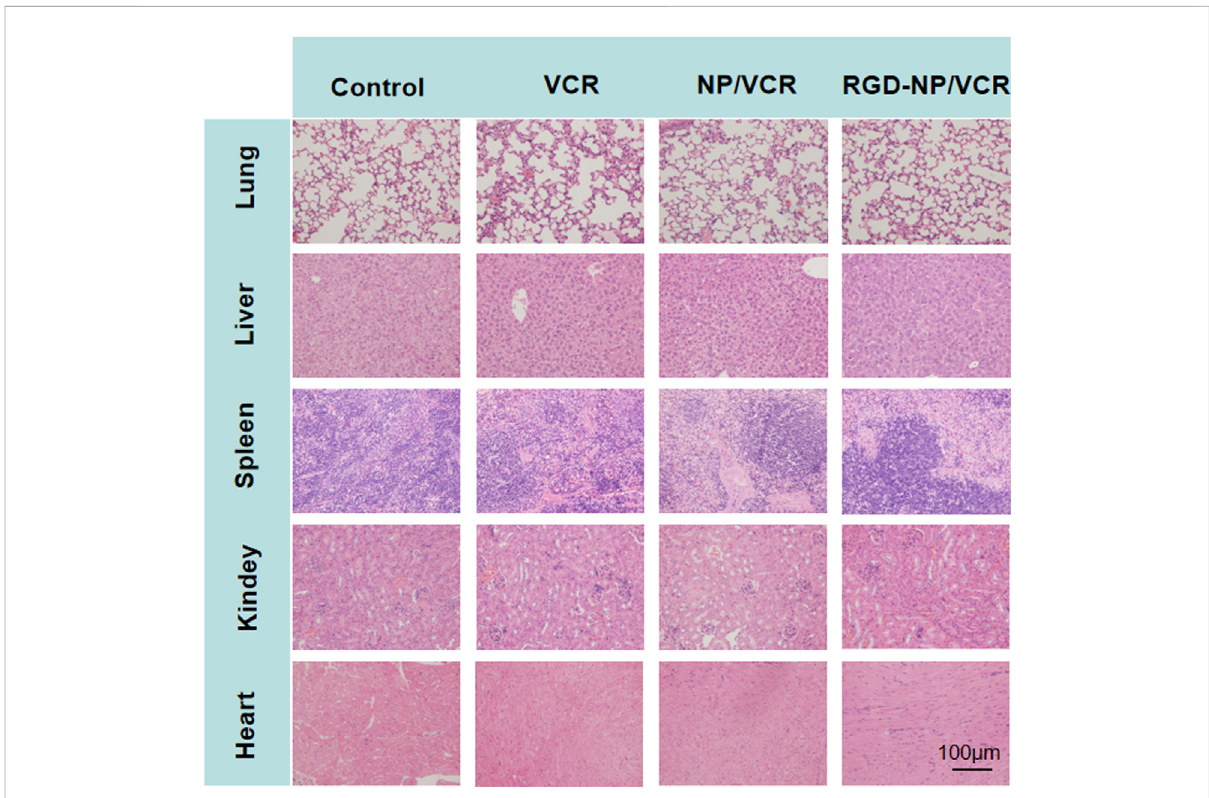
FIGURE 8 The histopathology of organs after treatment in each group (for lung, liver, spleen, kidney, and